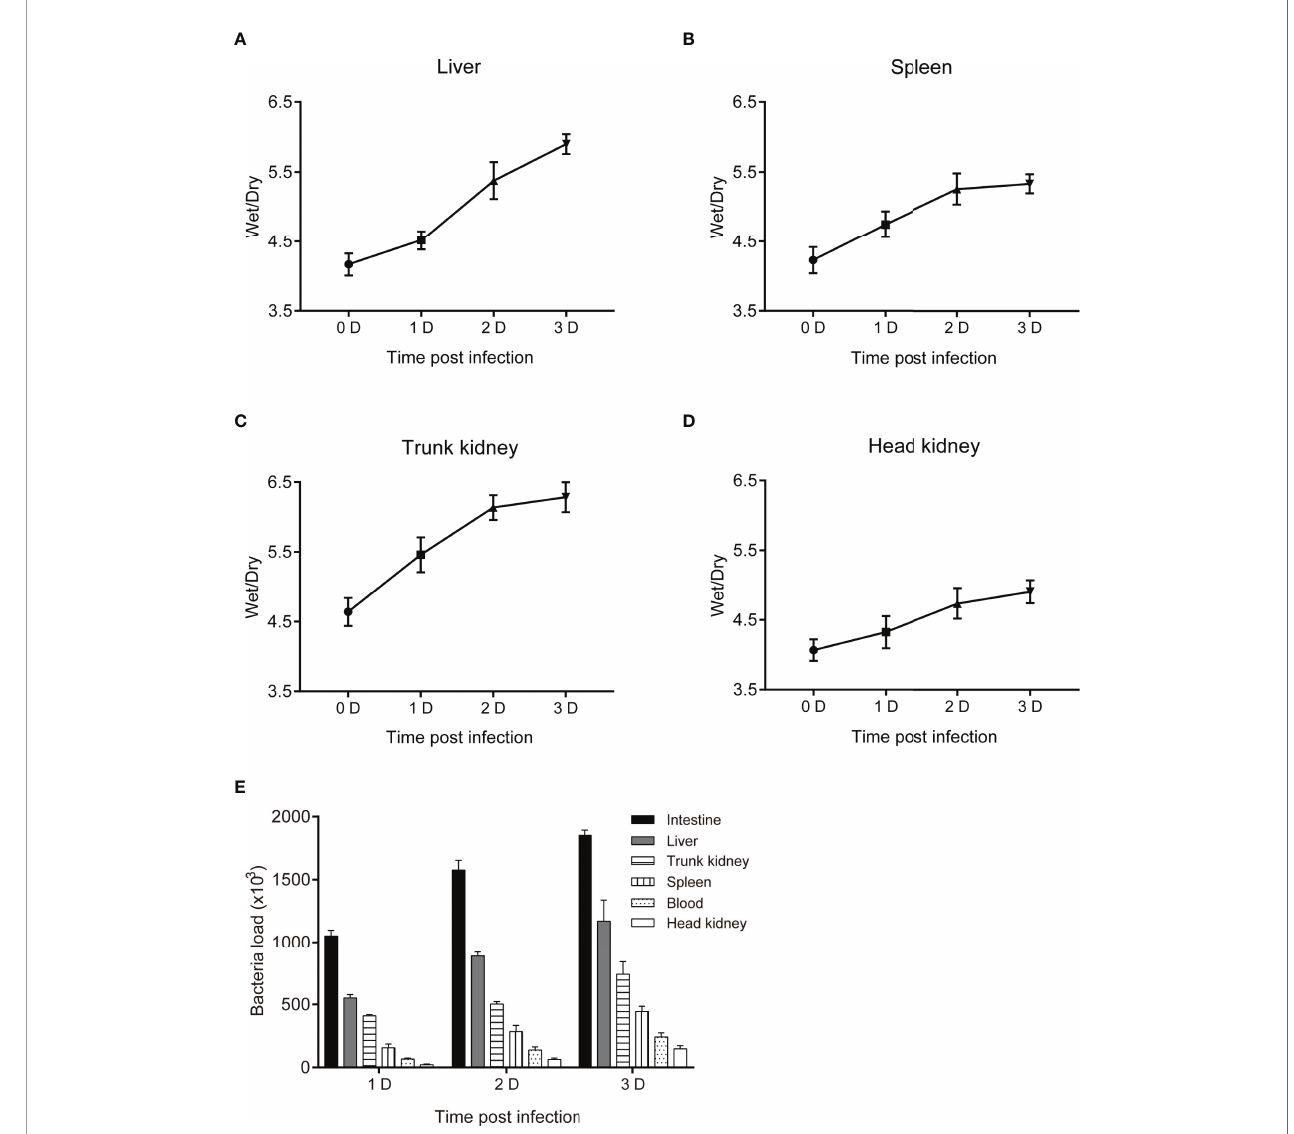
FIGURE 3 | Tissue edema and bacterial load in C. carpio after P. shigelloides challenge. (A – D) The dry/wet ratio of the liver, spleen, body kidney, and head kidney of C. carpio 0 – 3 days after P. shigelloides challenge. (E) Bacterial load in C. carpio tissues after P. shigelloides